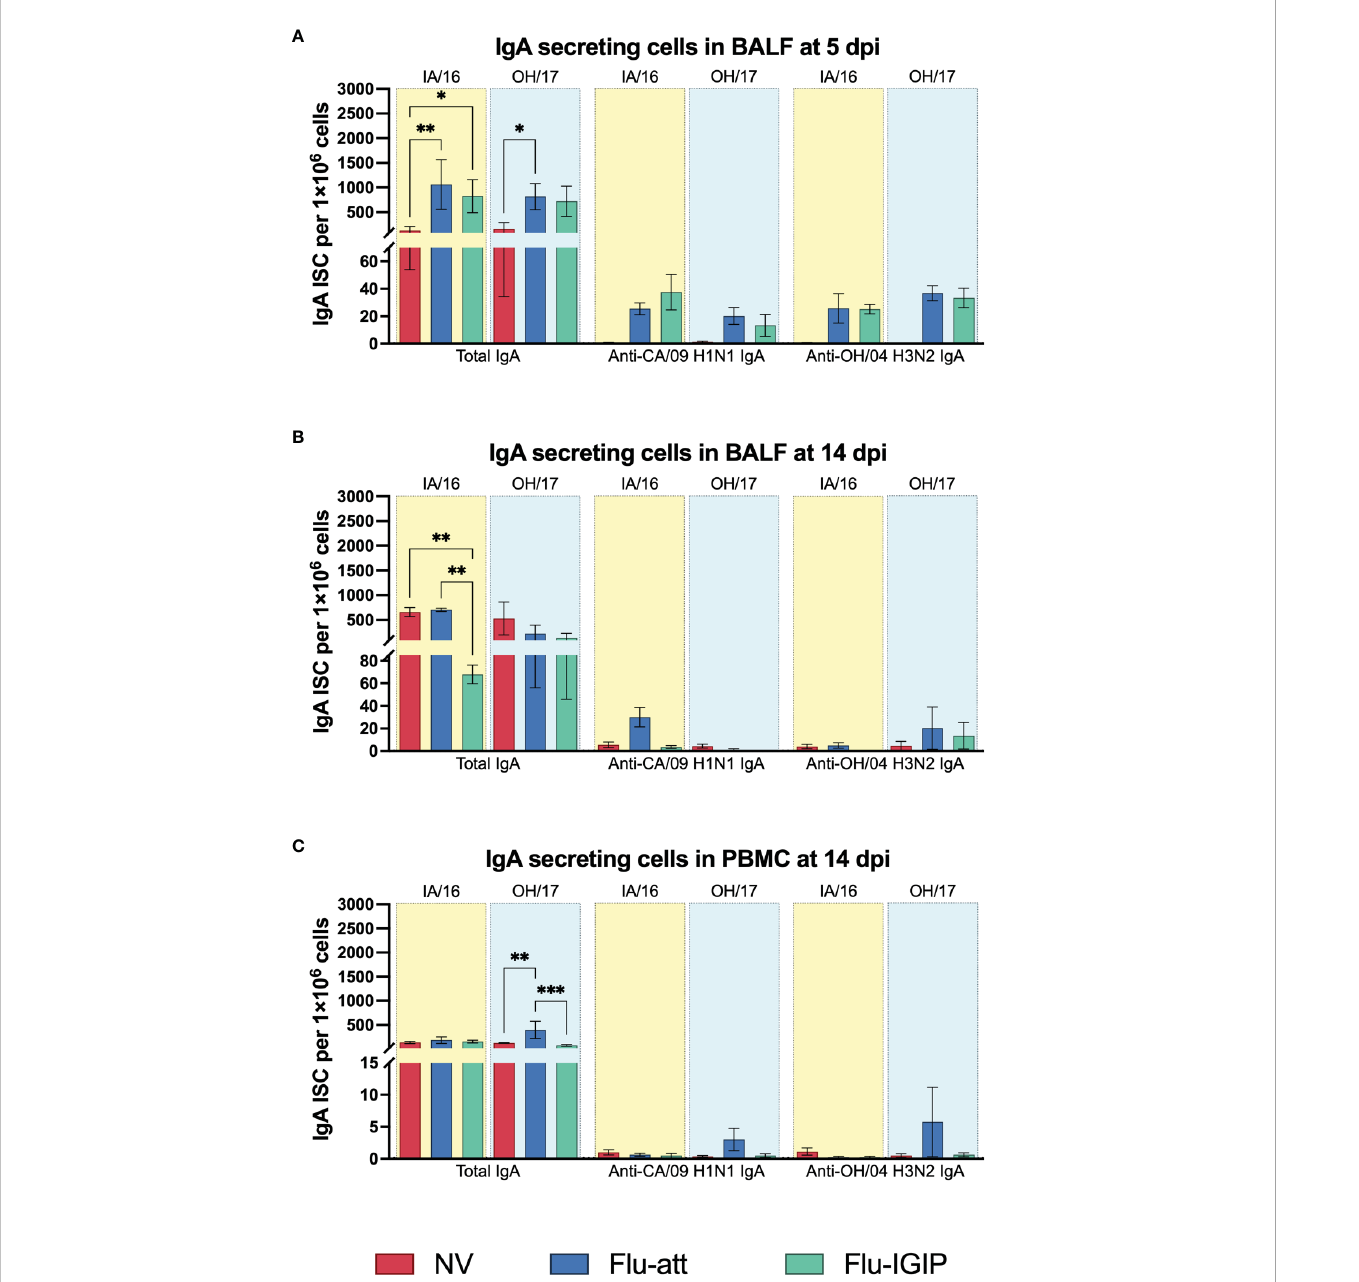
FIGURE 4 Total and in fl uenza-speci fi c systemic and local IgA secreting B cells after inoculation. Pigs were not vaccinated (NV, red bars) or vaccinated with bivalent Flu- att (blue bars) or Flu-IGIP (green bars) containing A/California/04/09 (CA/09 H1N1) and A/turkey/Ohio/313053/2004 (OH/04 H3N2) viruses. Pigs were challenged with A/swine/Iowa/A01778877/2016 (IA/16 H1N1, light-yellow boxes) or A/swine/Ohio/A01354299/2017 (OH/17 H3N2, light-blue boxes). Number of total and in fl uenza-speci fi c IgA secreting B cells (ISC) were determined by ELISpot in bronchoalveolar lavage fl uid (BALF) at (A) 5 and (B) 14 days post inoculation (dpi) and in peripheral blood mononuclear cells (PBMC) at 14 dpi (C) following B cell stimulation. Results displayed as mean spot counts ± standard error of the mean. *, p ≤ 0.05; **, p ≤ 0.01; ***, p ≤ 0.001 within groups challenged with the same